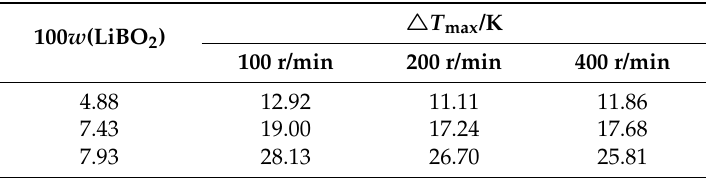
Table 2. Lithium metaborate with different stir rates.